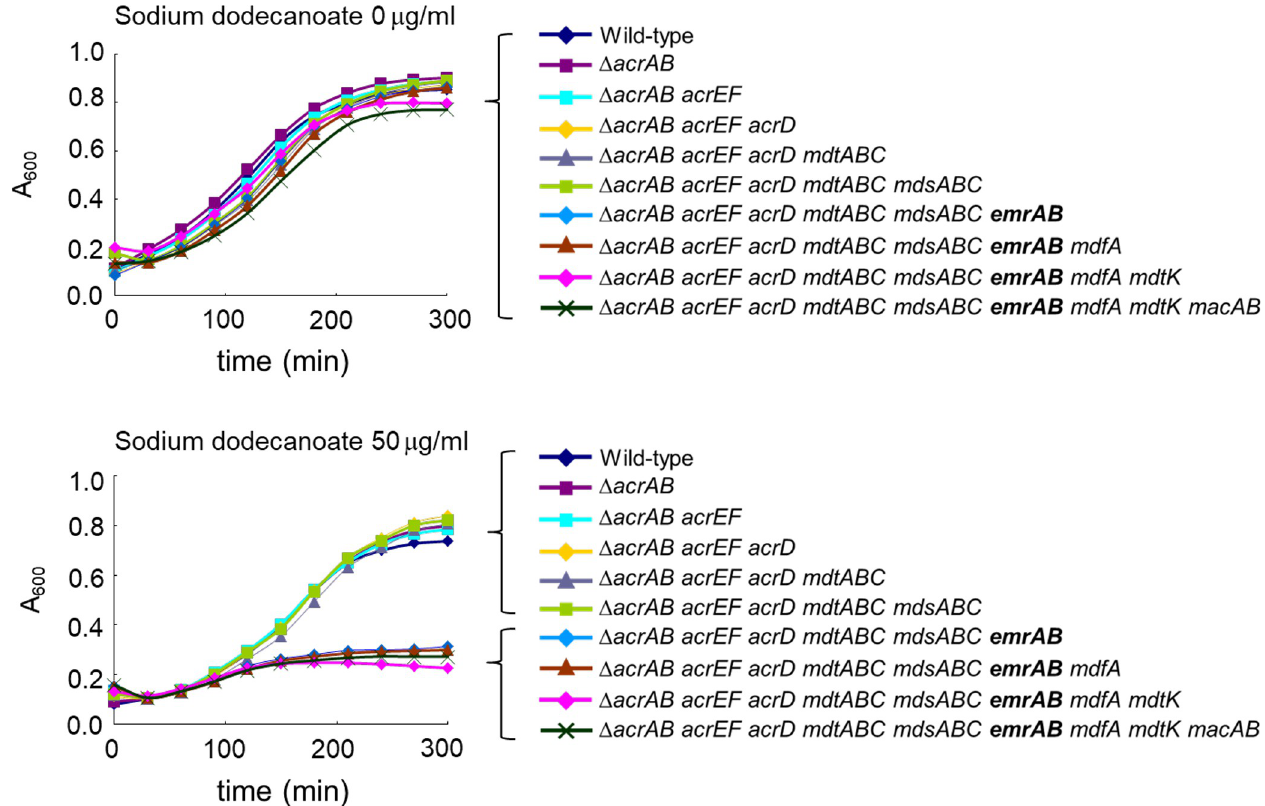
Fig 2. Effect of sodium dodecanoate on the growth of Salmonella enterica . The growth of S . enterica with stepwise deletion of multidrug efflux transporter genes was measured with or without sodium dodecanoate. Shown is the result of one of the three experiments, which gave similar